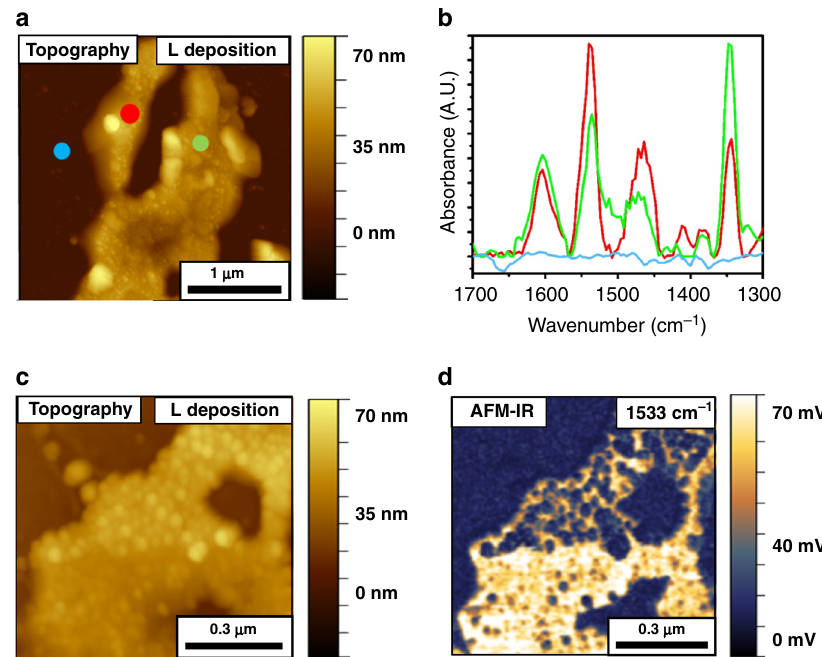
Fig. 5 AFM-IR measurements of NO 2 -NHCs that were deposited on Au fi lm by base-induced deprotonation. AFM topography ( a ) and AFM-IR point spectra measurements ( b ) following base-induced deprotonation deposition of NO 2 -NHCs on a patchy Au-coated Si substrate. Colored circles in a mark the local IR measurement positions and the measured IR spectra are shown in b with identical color-coding. Higher magni fi cation AFM topography image and the corresponding AFM-IR image at 1533 cm − 1 are shown in c and d ,